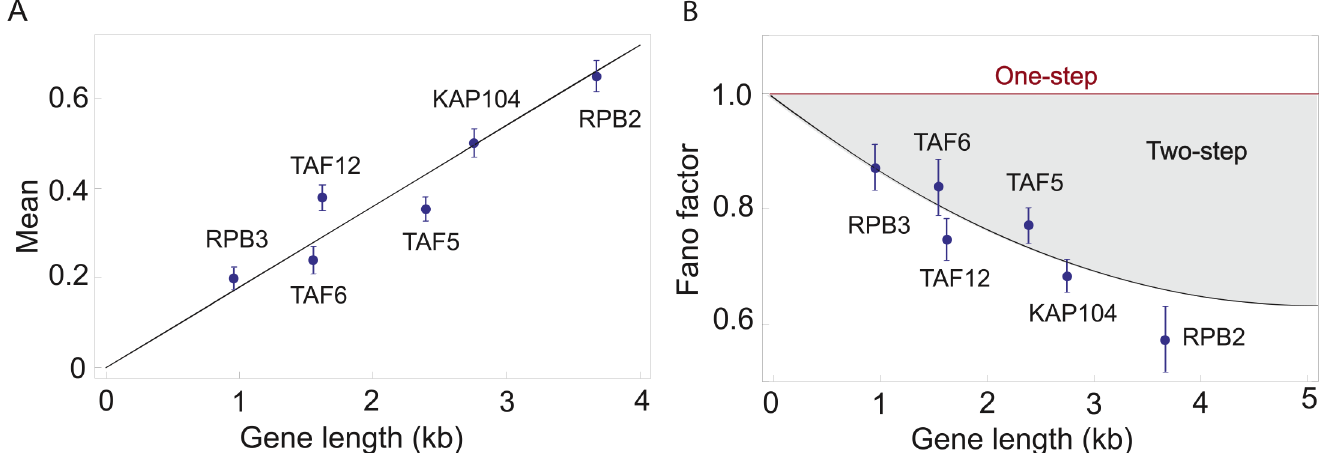
Fig 3. (A) Mean number of nascent RNAs for six different yeast genes. We use the nascent RNA distribution data for six constitutively expressed yeast genes: KAP104, TAF5, TAF6, TAF12, RPB2, RPB3 and plot the mean of the distributions as a function of the gene length. The mean of the distribution increases linearly with the gene length indicating that the transcription of all six genes is initiating at the same rate. The initiation rate of these genes extracted from the data is 0.145 ± 0.025/min, where the rate of elongation is taken to be 0.8 kb/min [4]. (B) Fano factor for the nascent RNA distribution of six different yeast genes. Using the data for the nascent RNA distributions for the same six yeast genes described in (A) we compute the Fano factor and compare it to predictions from our model. The shaded region shows the possible values that the Fano factor can take depending on the ratio of k LOAD and k ESC given the initiation rate determined from the mean in part (A). The boundary of the shaded region corresponds to the minimum amount of noise (as measured by the Fano factor) given the extracted rate of initiation in part (A), and it is obtained when the two rates are the same, i.e., k LOAD = k ESC = 0.29 ± 0.013/min. Interestingly enough the Fano factors characterizing the nascent RNA distribution for these six yeast genes seem to lie on this boundary. (The nascent RNA data for the six yeast genes used in our analysis is taken from ref.